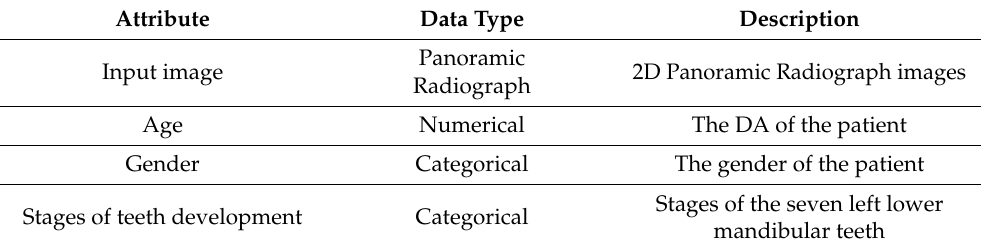
Table 1. Dataset attributes with type and description.